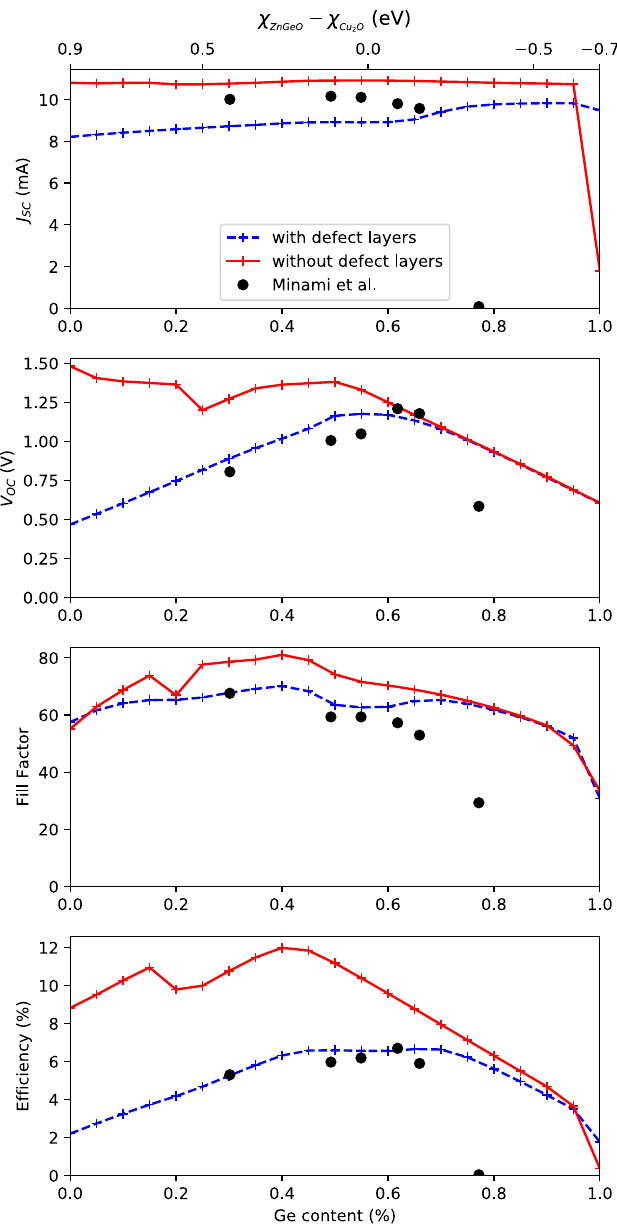
Fig. 1. Simulated photovoltaic characteristics of the AZO/Zn 1 (cid:1) x Ge x O/Cu 2 O solar cell for different germanium composition x or conduction band offset x ZnGeO (cid:1) x Cu tions with (dashed blue) and without (solid red) using interfacial defect layer at the junction are compared with experimental measurements (black dots) from